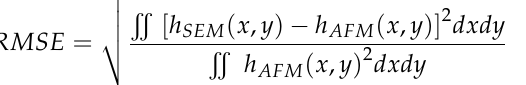
Figure 5. 2D crater images retrieved using TIE from digitally processed SEM-images: ( a , d ) no boundary conditions; ( b , e ) Neumann boundary conditions; ( c , f ) Dirichlet boundary conditions.